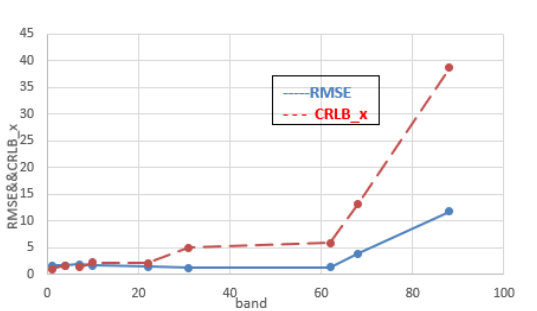
Figure 2 Trend chart of RMSE and CRLB_x